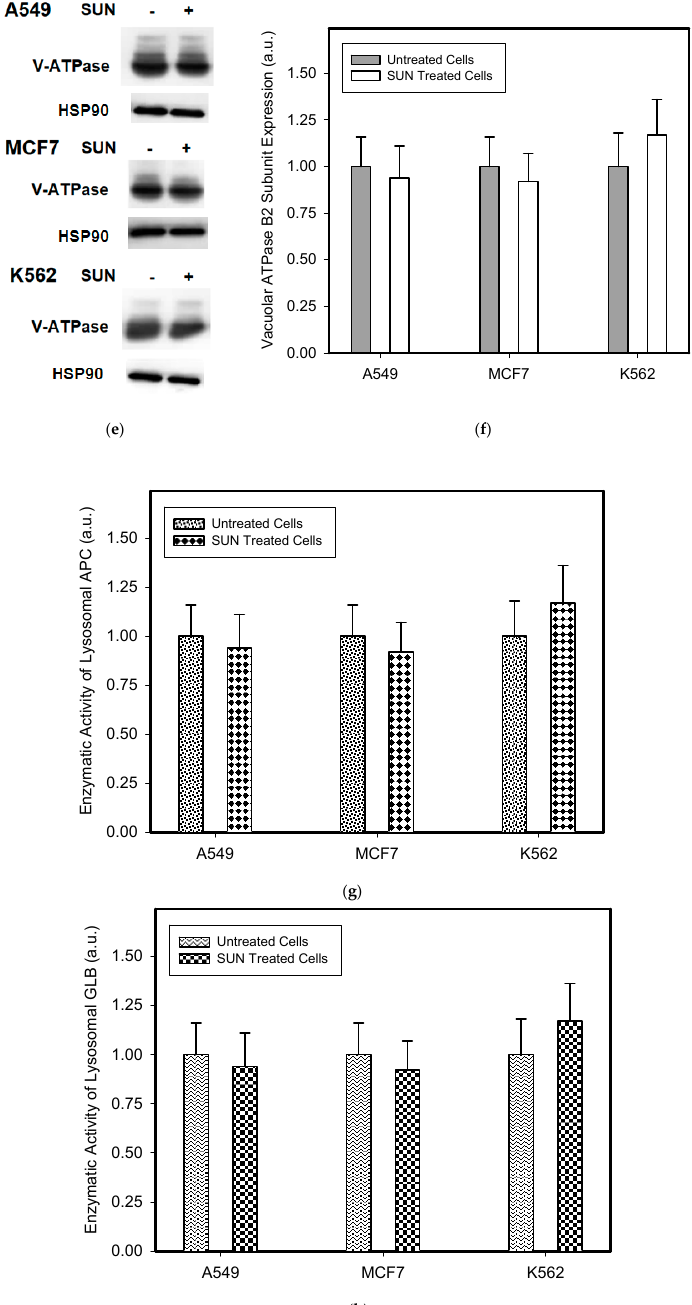
Figure 7. The effect of SUN on the expression of lysosomal proteins in cancer cells. Cells were cultured for 3 days in the presence of 1 μ M SUN under standard conditions. Cells cultured in medium without SUN were taken as controls. ( a ) Western blot analysis of LAMP1 (typical analysis). ( b ) Quantitative analysis of LAMP1 expression using densitometry. ( c ) Western blot analysis of LAMP2 (typical analysis). ( d ) Quantitative analysis of LAMP2 expression using densitometry. ( e ) Western blot analysis of vacuolar ATPase subunit B2 (typical analysis). ( f ) Quantitative analysis of vacuolar ATPase subunit B2 using densitometry. ( g ) Enzymatic activity of lysosomal APC. ( h ) Enzymatic activity of lysosomal GLB. Columns represent the means and standard deviations of four independent